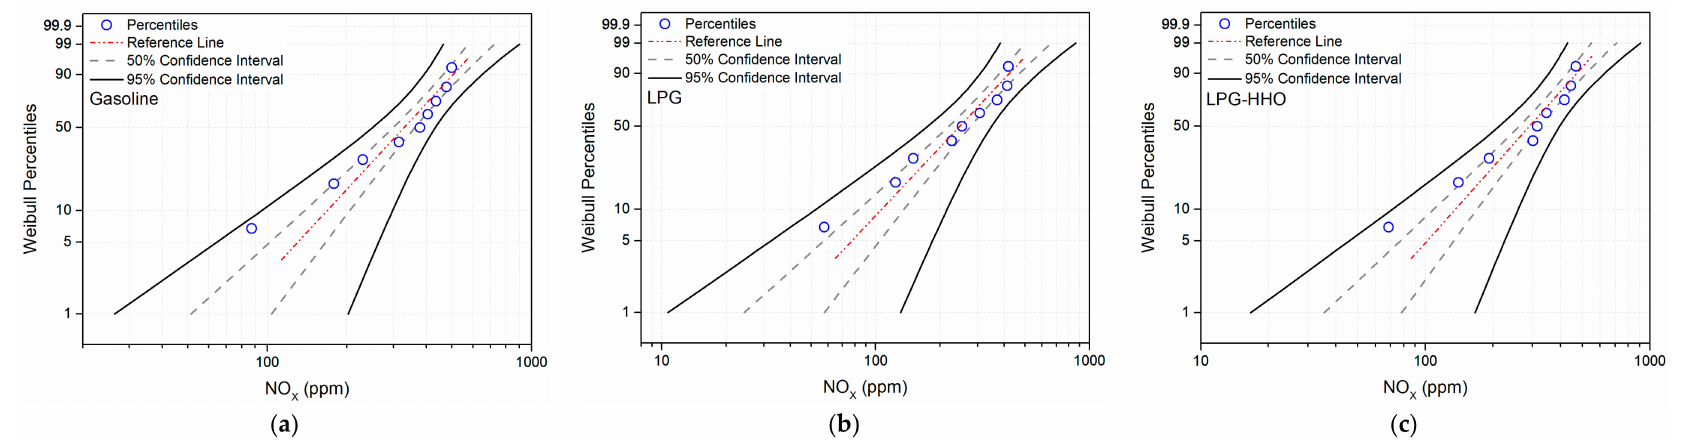
Figure 7. ( a – c ) Weibull probability plot of HC for 50% and 95% CI using gasoline, LPG and LPG-HHO respectively.